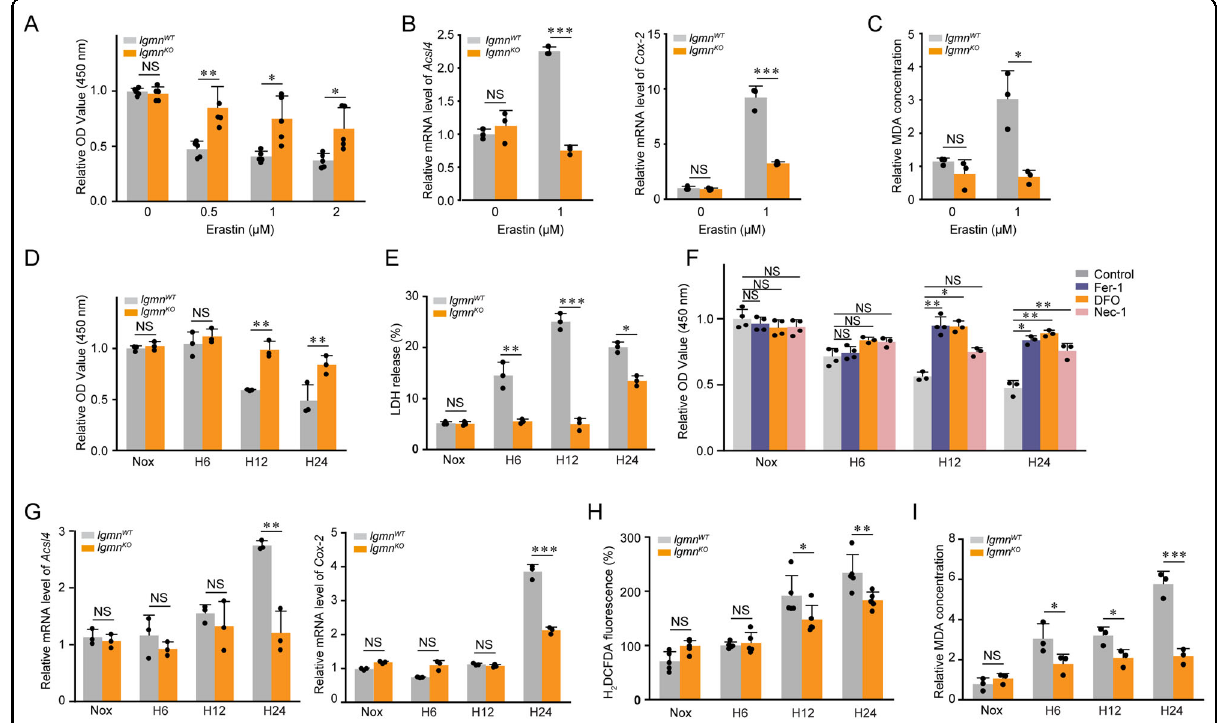
Fig. 4 Downregulation of legumain suppresses ferroptosis in tubular cells. Primary mouse tubular epithelial cells were isolated from lgmn WT and lgmn KO mice. mRTECs were treated with 0.5, 1, and 2 μ M erastin for 24 hours. A Cell survival was measured by CCK-8 assays. Data were collected from three independent experiments. B Quanti fi cation of Acsl4 and Cox-2 mRNA levels by qPCR. C Lipid peroxidation levels were measured by MDA assay. mRTECs were incubated under normoxic or hypoxic conditions for 6, 12, and 24 h. D Cell survival was measured by CCK-8 assays. E Cell lysates and supernatants were collected at the indicated time points for LDH release assays. F mRTECs were incubated under normoxic or hypoxic conditions for 6, 12, and 24 hours, with or without pretreatment of 2 hours of Fer-1 (1 μ M), DFO (10 μ M) or Nec1 (5 μ M). Cell survival was determined 24 h thereafter using CCK-8 assays. G Quanti fi cation of Acsl4 and Cox-2 mRNA levels by qPCR. H Intracellular ROS levels were measured using the fl uorescent probe